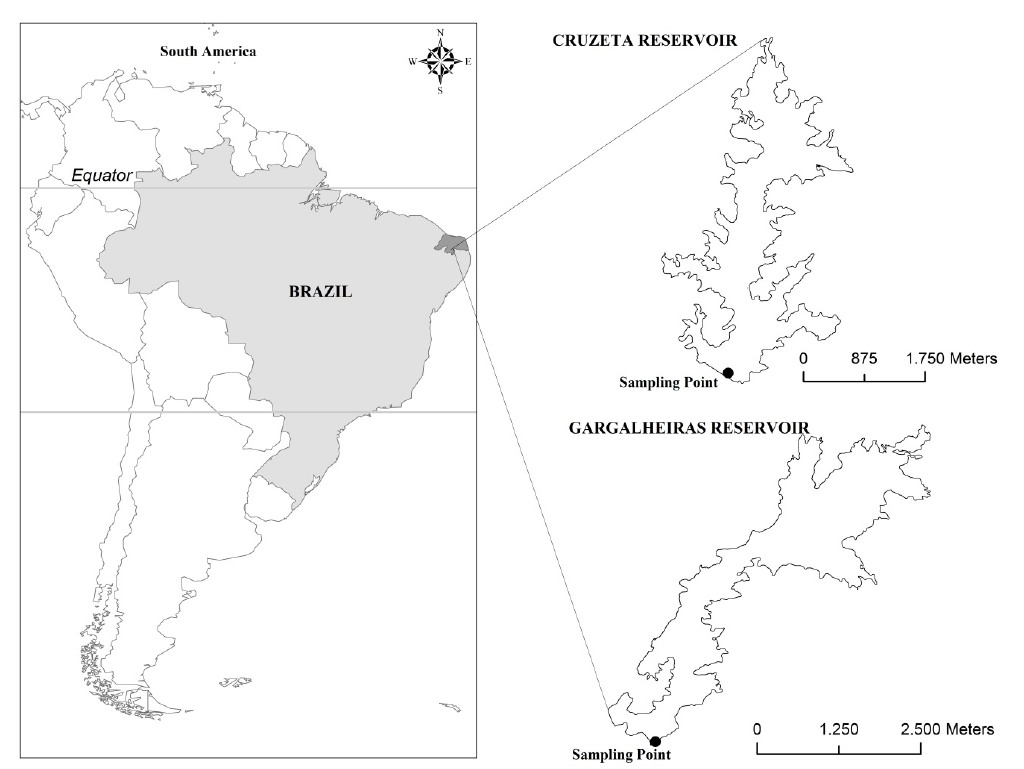
Figure 1. Location of the Gargalheiras and Cruzeta reservoirs and the sampling points near their respective